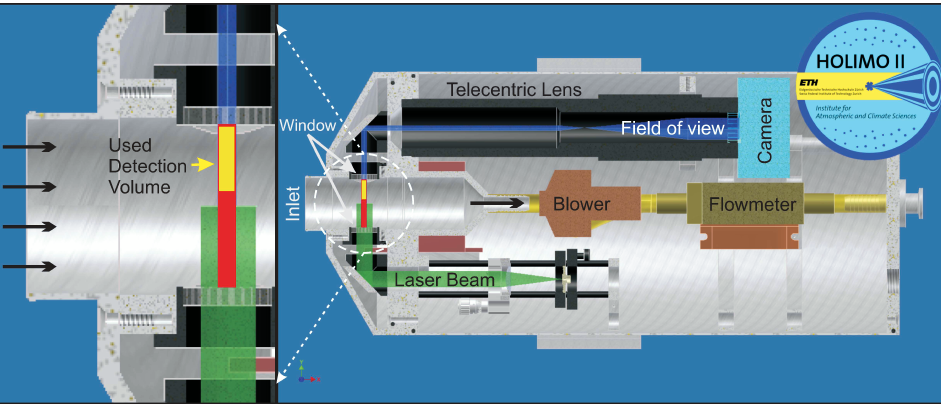
Fig. 2. A horizontal cross section of the HOLIMO II inlet box, showing the major components. The inlet tip is magnified in a blowup (left panel). Particles are drawn in through the inlet (from the left) by a blower (in the center) to scatter light from the laser beam (green). The detection volume (red and yellow) is limited by the field of view of the optical system (blue) and the two windows (top and bottom edges of red region). For measurements, only that part of the detection volume where the highest resolution could be achieved was used